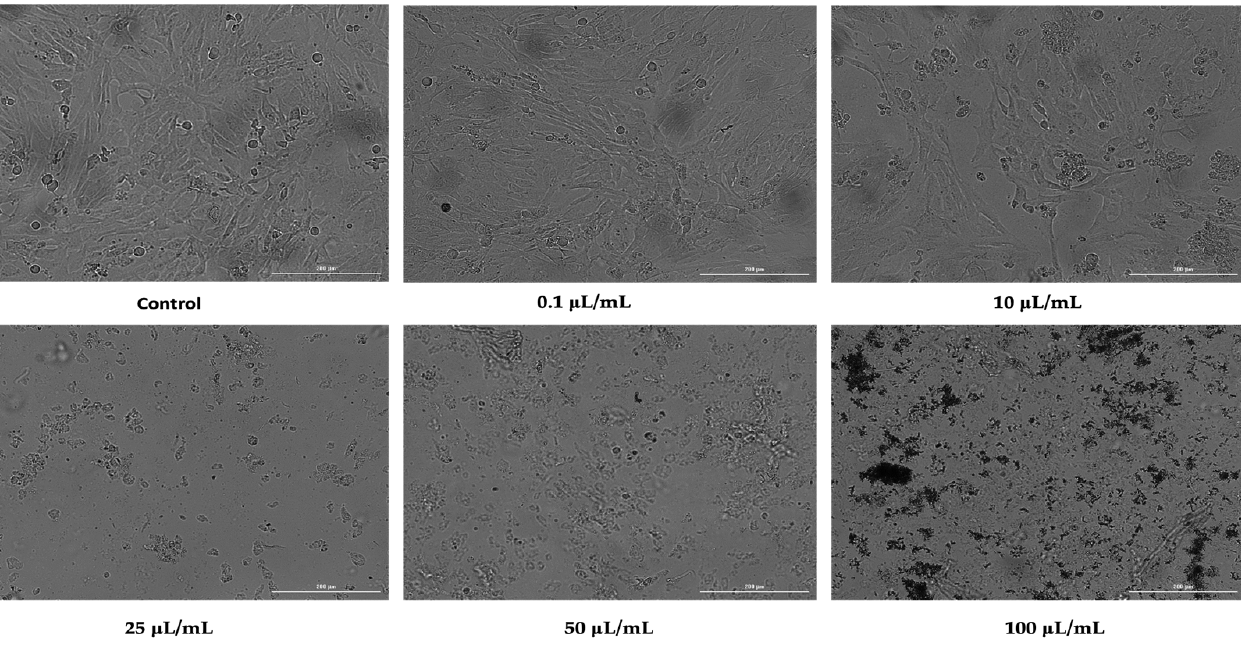
In H9C2 (2-1) cells, nicotine had a similar effect on morphology to that observed in